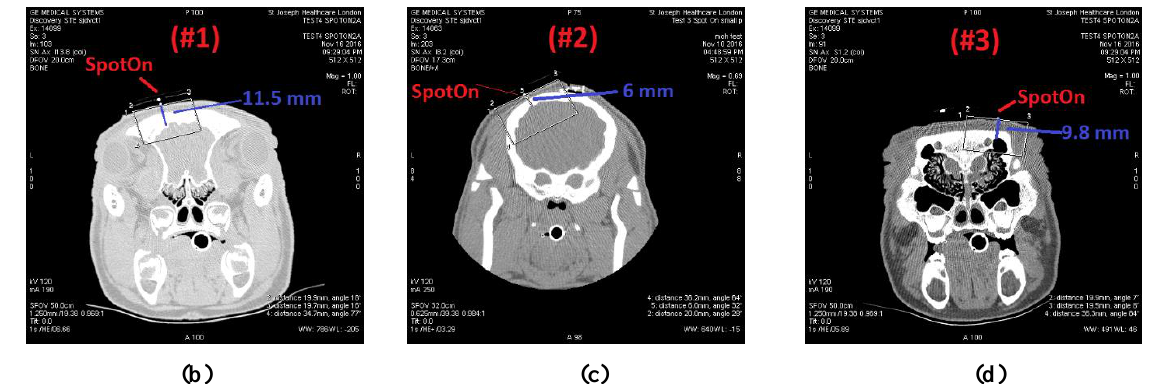
Figure 1. (a) Schematic of a pig’s head showing the different approximate locations (#1-3) of the SpotOn patches and estimated position of the needle thermocouple probe to measure brain temperature. (b-d) Coronal CT images showing the location of center of SpotOn patches and extra cerebral tissue i.e., scalp and skull thickness associated with each location. White lines in rectangle shape shows the region of interest below the whole SpotOn